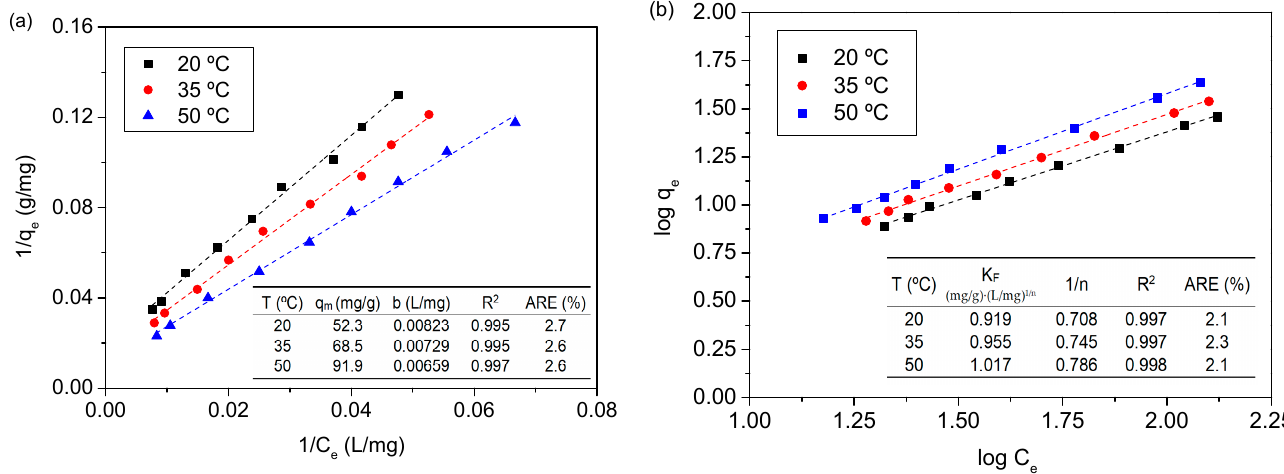
Figure 12. ( a ) Langmuir and ( b ) Freundlich adsorption isotherms for pseudoboehmite (experimental conditions: adsorbent dosages from 1.5 to 20 g/L, 16 h contact time).